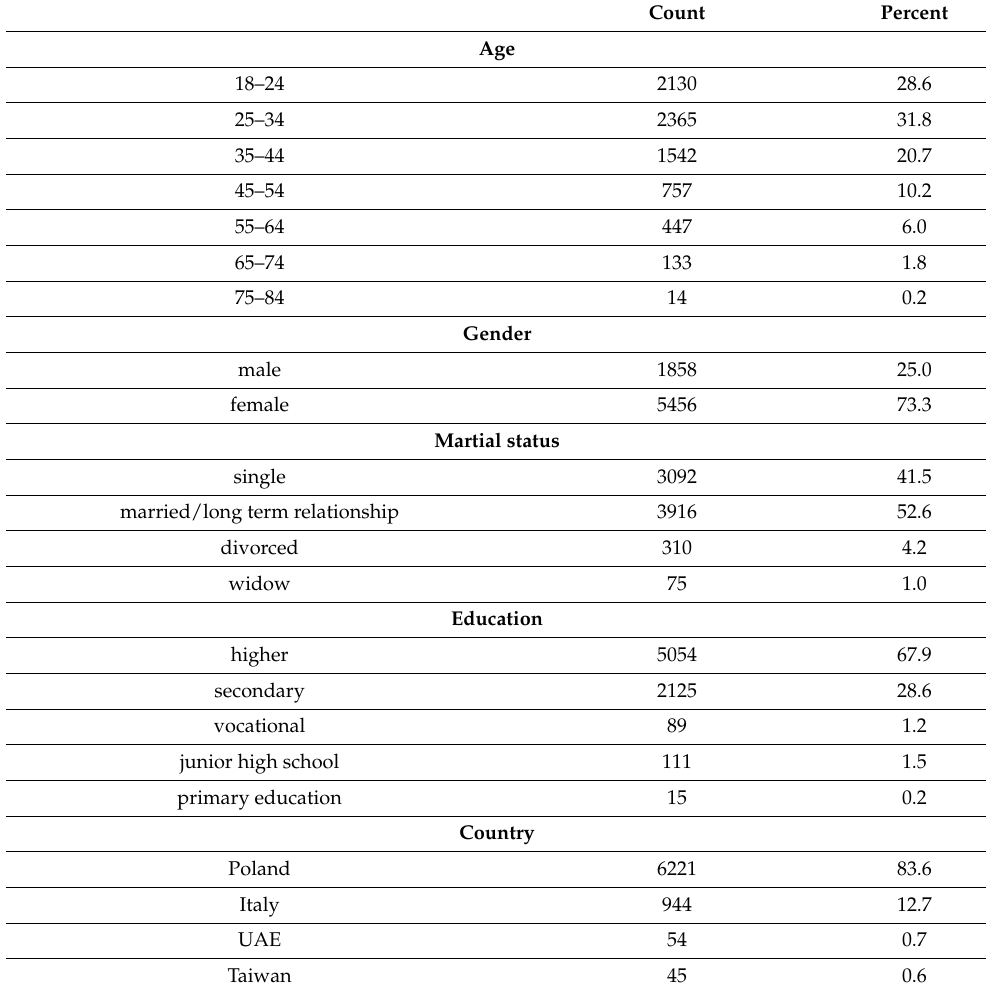
Table 1. Characteristics of the study